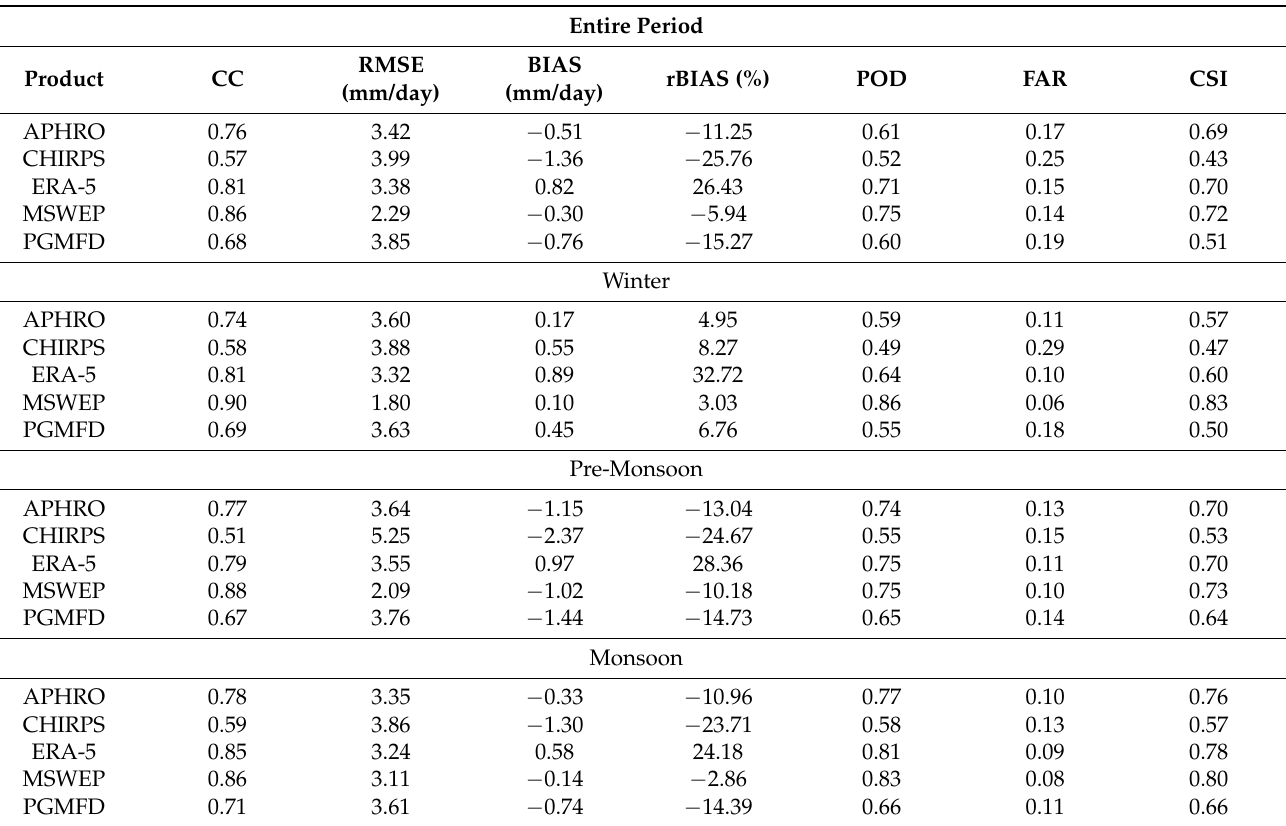
Table 4. The statistical metrics for daily performance evaluation of GPPs in contrast to in-situ gauges data during the entire study period 1981–2009 with different